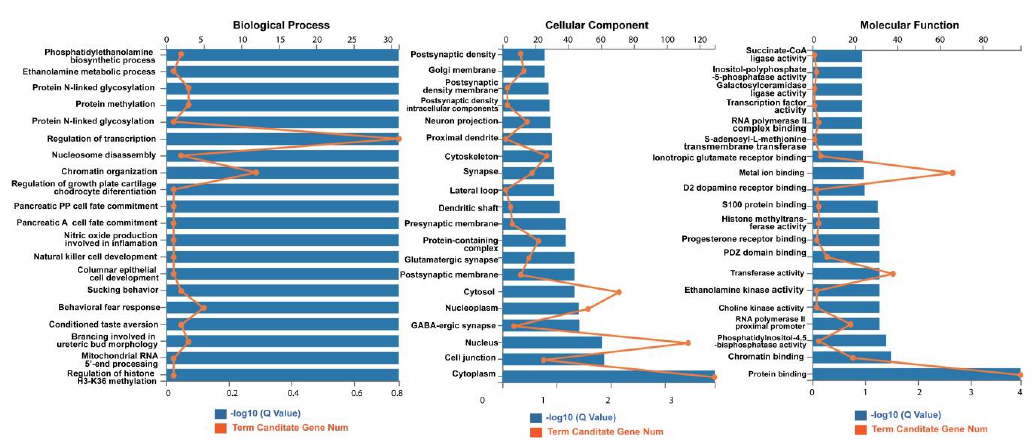
in reaction group; and Charcot–Marie–Tooth disease and Joubert syndrome” (Q = 0.16) in disease group (Figure 9). In particular, they seem to function in “adrenergic signaling in cardiomyocytes” (Q = 0.05) (Figure 10).